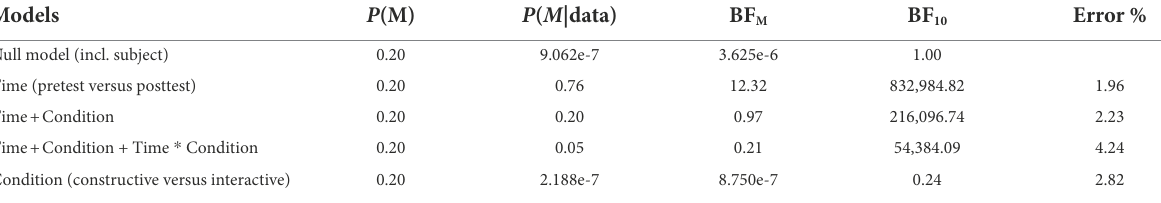
TABLE 2 Model comparison for the Bayesian repeated measures ANOVA on knowledge.